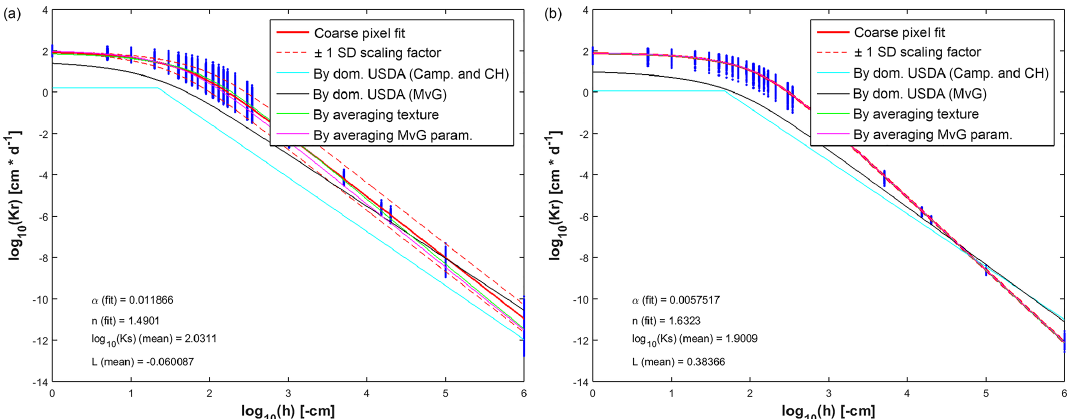
Figure 9. Hydraulic conductivity curves for Lower Saxony (left) and North Rhine-Westphalia (right). The coarse pixel fit is the result of the Warrick scaling approach, where (log 10 ˆ λ i ) was also estimated. Therefore, ± 1SD(log 10 ˆ λ i ) could also be provided to identify the sub-grid uncertainty. Further hydraulic conductivity curves were calculated by dominant USDA class (both for Brooks and Corey with Clapp and Hornberger and for MvG equation), by averaging texture and by averaging MvG parameters. Blue points indicate log 10 ( K r ) at standard hydraulic heads for each individual subpixel.